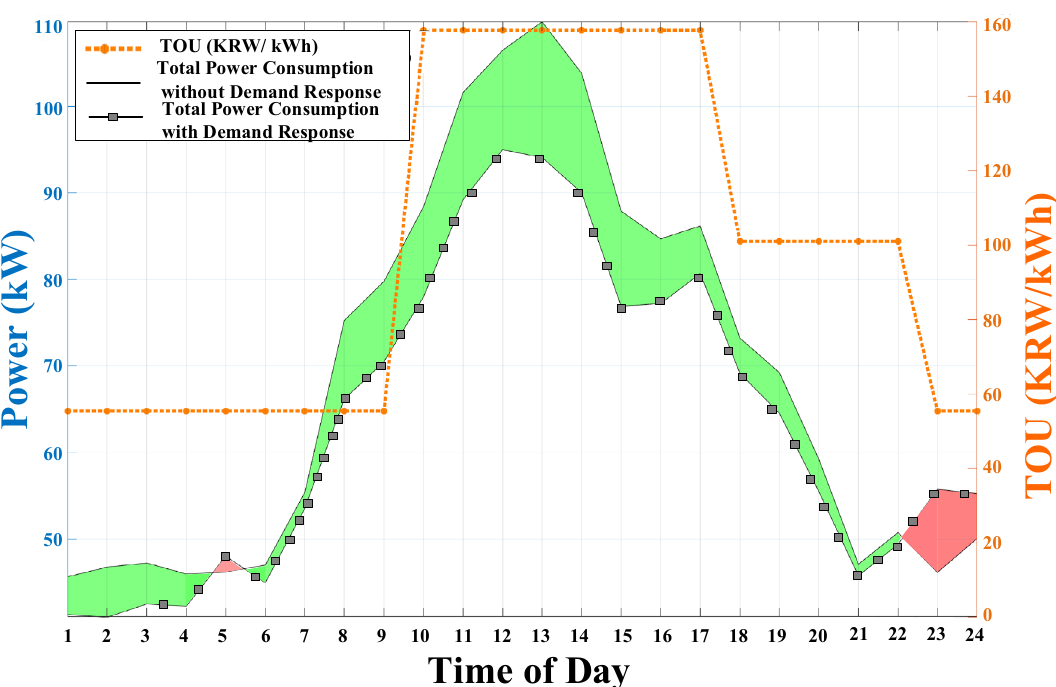
Figure 11. Total residential power consumption with and without